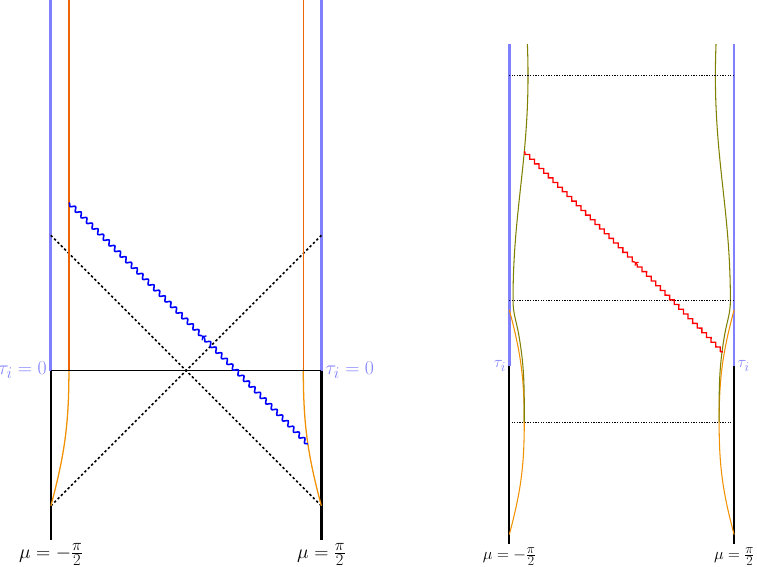
Figure 3 . On the left we depict a transitional con(cid:12)guration of the black hole to ETW where the L- R boundary interaction is turned on at ~ u i = 0. On the right we depict a transitional con(cid:12)guration of the black hole to an excited (oscillatory) ETW state where the L-R boundary interaction is turned on at ~ u i > 0. Signals sent before turning on the L-R interaction through the bulk channel emerges to the other side after some amount of time with modulated frequencies, which is a clear evidence of the existence of the bulk channel and